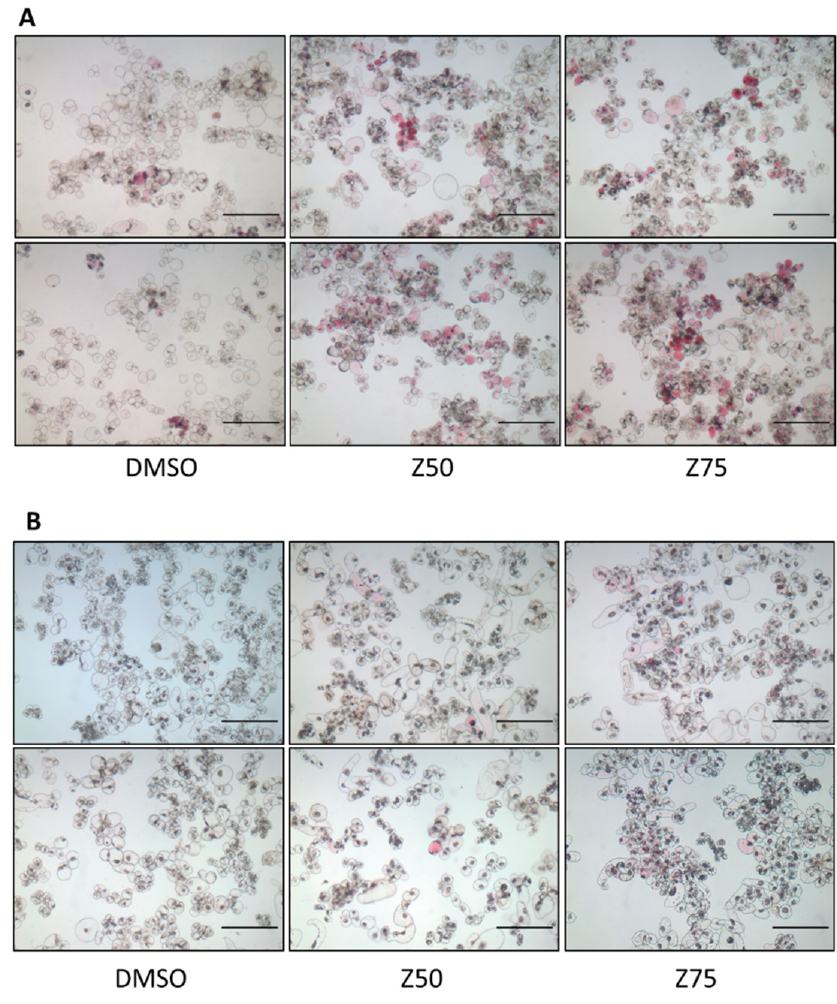
Figure 3. GT cell suspensions are heterogeneous: only a limited number of cells accumulate anthocyanins. Treatments with zebularine were performed 3 days after sub-culturing in the light ( A ) and the dark ( B ). Nine days after zebularine addition, cells were harvested, and microscopic observations were performed with an Axiophot Fluorescent microscope (Zeiss, Oberkochen, Germany) in brightfield mode. Bars = 250 µ m.